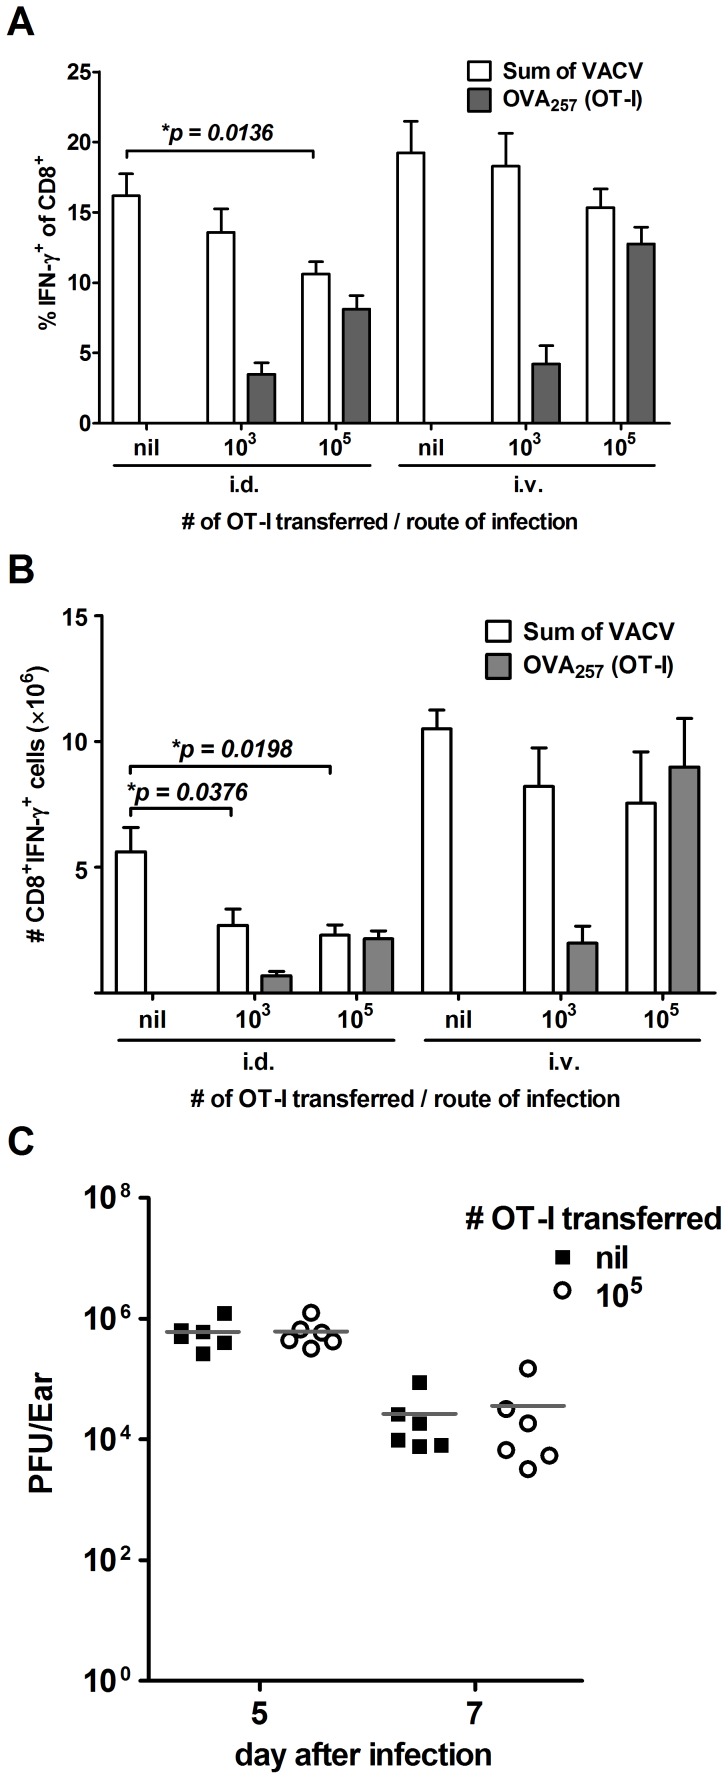
Greater cross-competition from transferred OT-I cells after peripheral infection.A–B) B6.SJL mice were infected with 1×106 PFU of VACV NP-S-GFP by i.d. or i.v. injection a day after receiving the numbers of OT-I CD8+ T cells as shown. Seven days later, CD8+ T cell responses to 15 VACV epitopes plus OVA257 were measured by intracellular staining of IFN-γ. OT-I T cells were identified by expression of CD45.2. CD8+ T cells responding to VACV (as a sum of all 15 peptides) and OT-I CD8+ T cells responding to OVA257 are show as a percent of all CD8+ T cells (A) and as a total number of CD8+ IFN-γ+ cells per spleen (B). Graph shows the average ± SEM and data come from two independent experiments and a total of at least 4 mice for each route and dose of OT-I cells. Statistical significance denoted with p value over appropriate bars. C) B6.SJL mice that received the number of OT-I CD8+ cells as shown were infected with 1×106 PFU of VACV NP-S-GFP i.d.. On day 5 and 7 post-infection, virus titers in the ear pinnae were determined by plaque assay. Data are titers from individual ears and the grey bar represents the average.